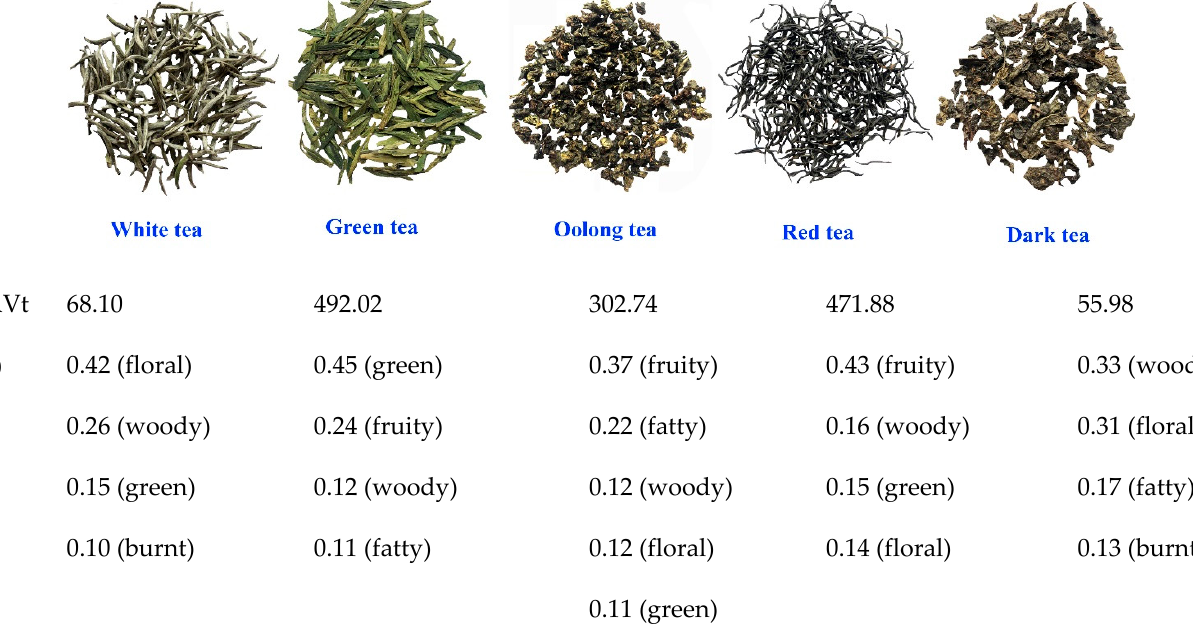
Figure 2. The OAVt and I(o) of tea with different types.